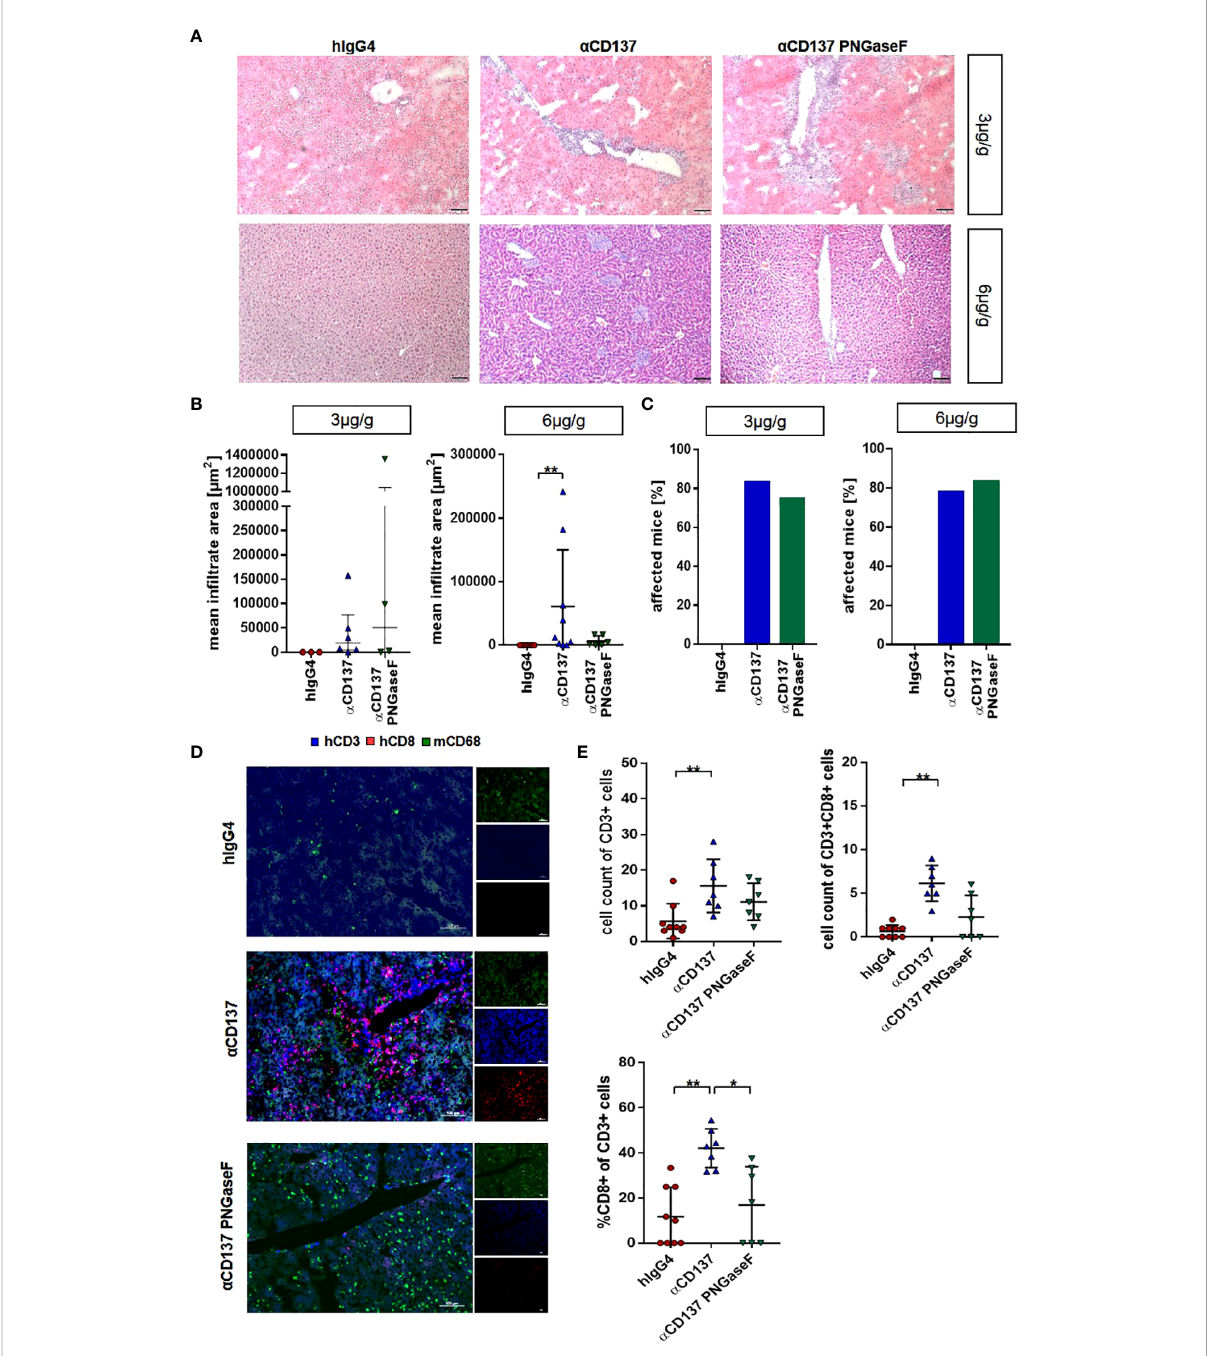
FIGURE 7 Impact of treatment with urelumab variants on liver pathology. Humanized mice received either 3 or 6µg/g of a human IgG4 isotype control, urelumab ( a CD137) or deglycosylated urelumab ( a CD137 PNGaseF) and liver pathology was studied twenty days after antibody injection. (A, B) Representative hematoxylin/eosin stained liver sections (A) of mice treated with 3 or 6µg/g of human IgG4 isotype control, urelumab and deglycosylated urelumab variants (scale bar 100µm) and quanti fi cation of the mean in fi ltrate area (B) of immune cell in fi ltrates (hIgG4: n=3, a CD137: n=6, a CD137 PNGaseF: n=4). (C) Shown is the percentage of mice with detectable immune cell in fi ltrates in the liver. (D, E) Immuno fl uorescent staining of liver sections (scale bar 100µm) (D) and quanti fi cation of the in fi ltration (E) of CD3+ T cells (upper panel) and the relative amount of CD3+CD8+ T cells within the CD3+ T cell population (lower panel) (hIgG4: n=9, a CD137: n=7, a CD137 PNGaseF: n=7, n represents the number of analysed images of two independent mice per group). Statistical testing was performed by using a Shapiro-Wilk and Kruskal Wallis test with a Dunn ’ s multiple comparison test. *p<0.05;